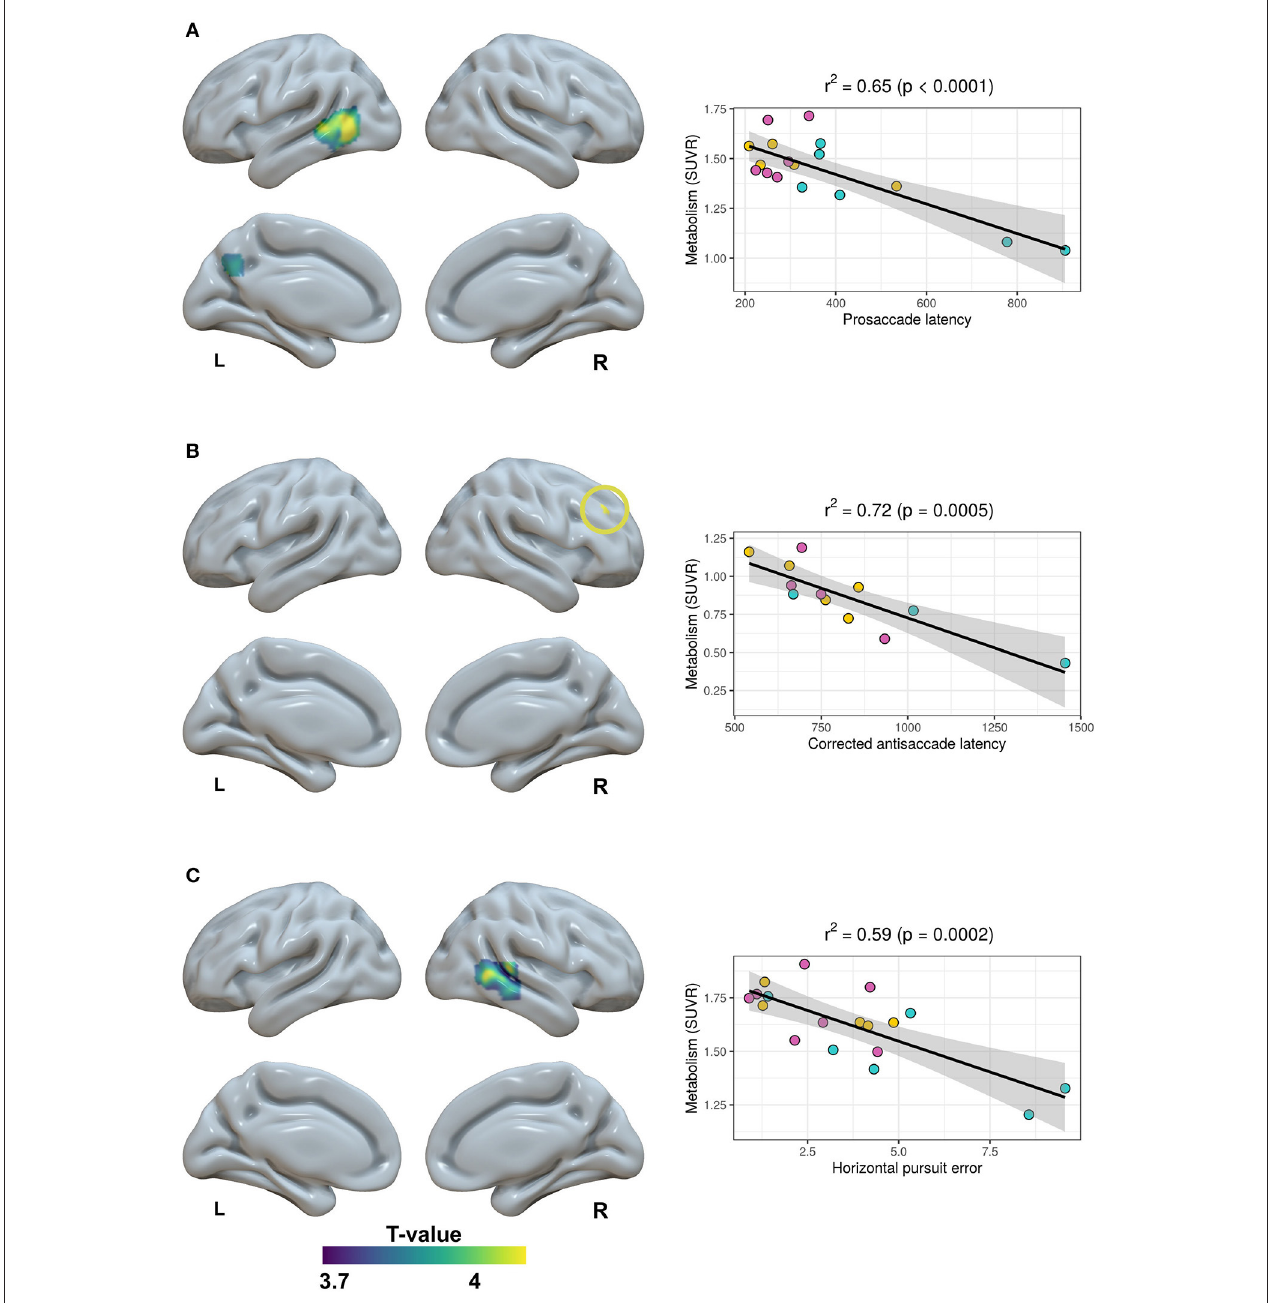
FIGURE 5 | Relationship between brain metabolism and horizontal prosaccade latency (A) , horizontal corrected antisaccade latency (B) and horizontal pursuit error (C) . SUVR, Standard Uptake Value Rate.